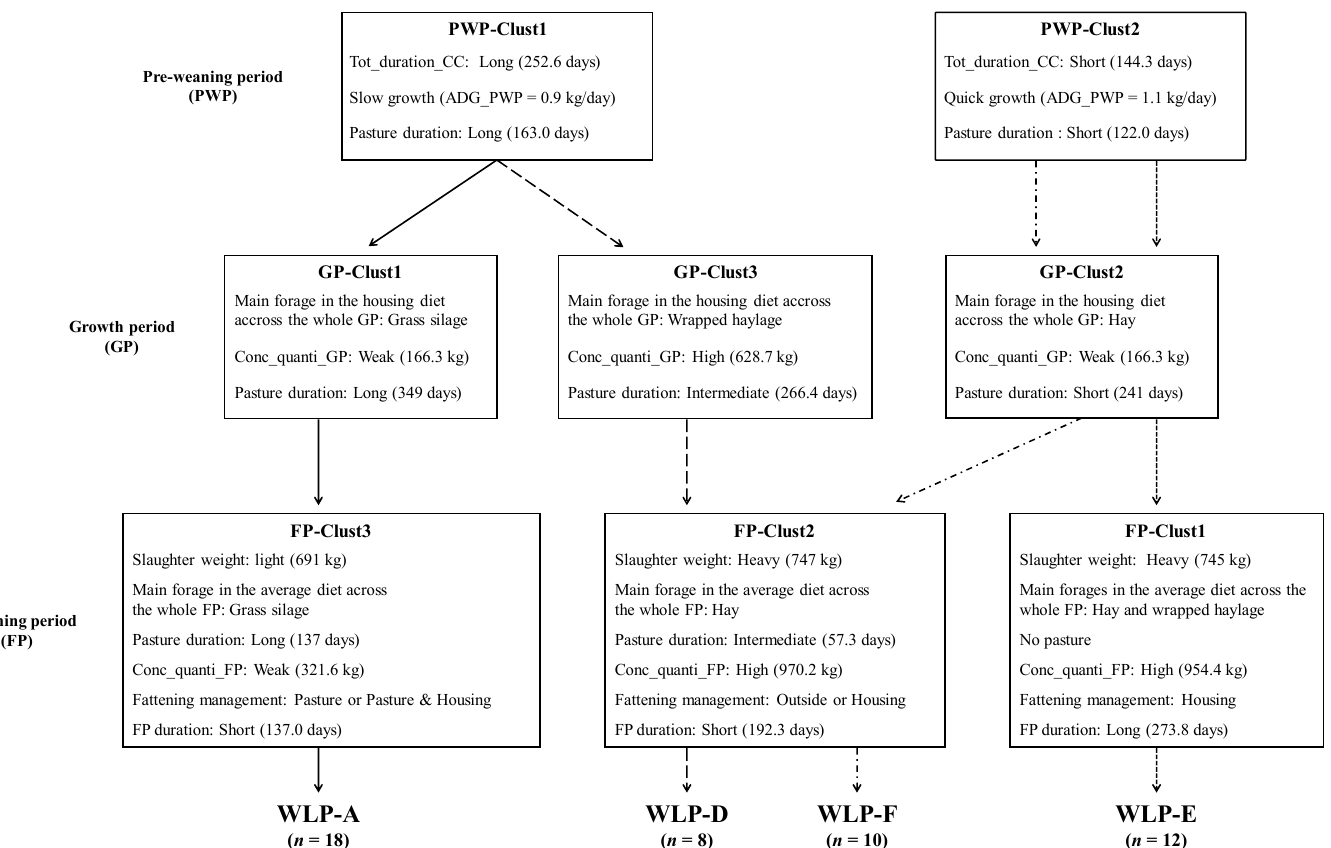
Figure 1. Description of the four rearing managements applied during the heifers’ whole life period (WLP) defined by Soulat et al. [10] with a focus on the rearing factors with the most differences between groups. Tot_duration_CC: Total time spent by the calf with her mother between the birth and the weaning, ADG: Average daily gain, Conc_quanti: Total concentrate quantity intake during the period of heifers’ life.